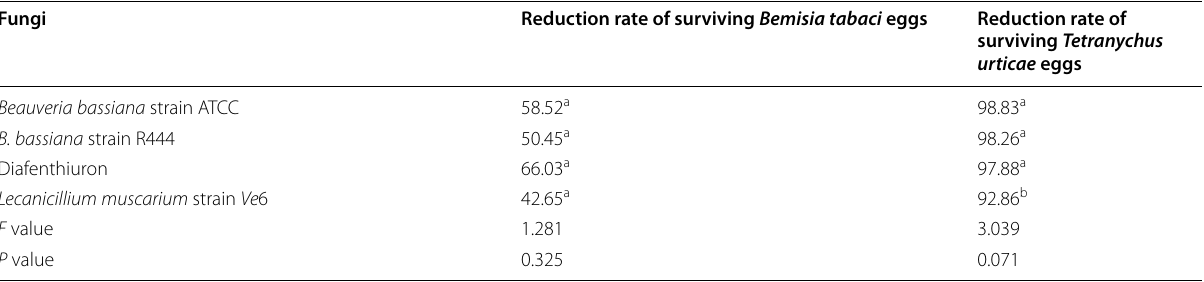
Different letters denote means are significantly different from one another, as determined by Duncan